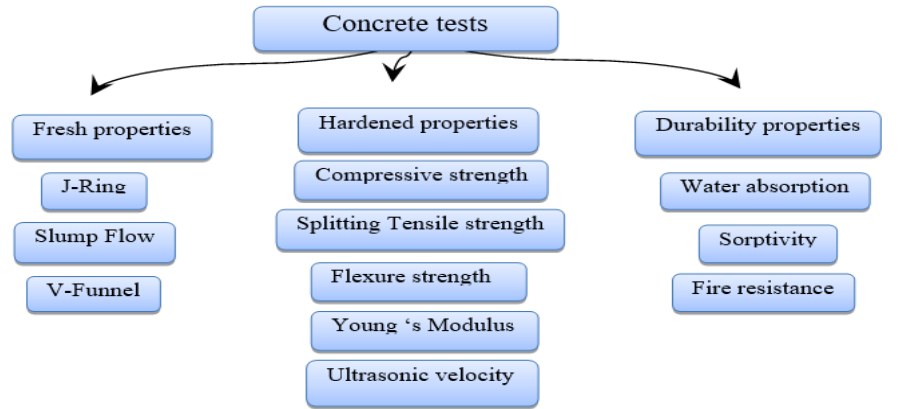
Figure 4. Fresh, hardened, and durability